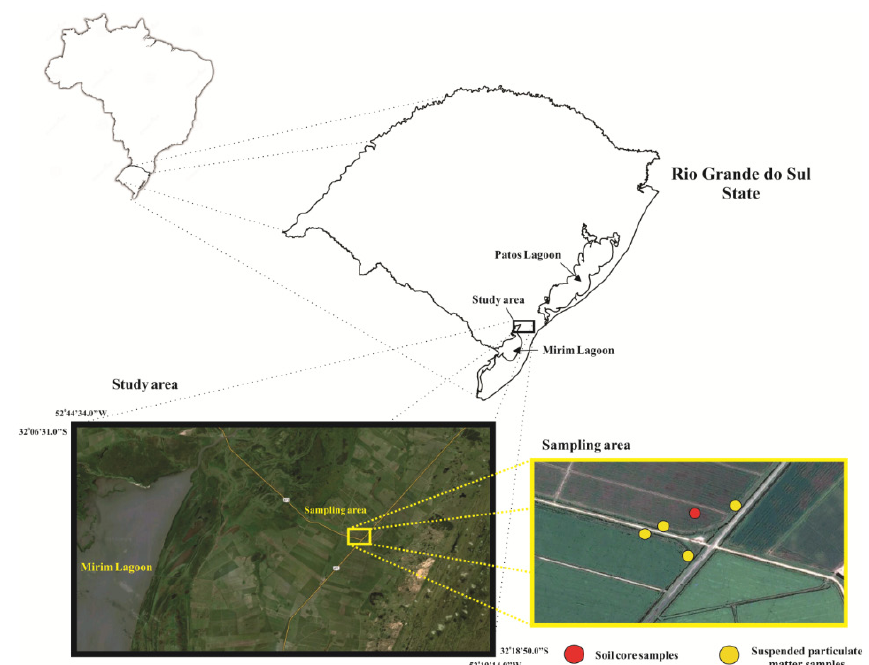
Figure 1. Location of the sampling